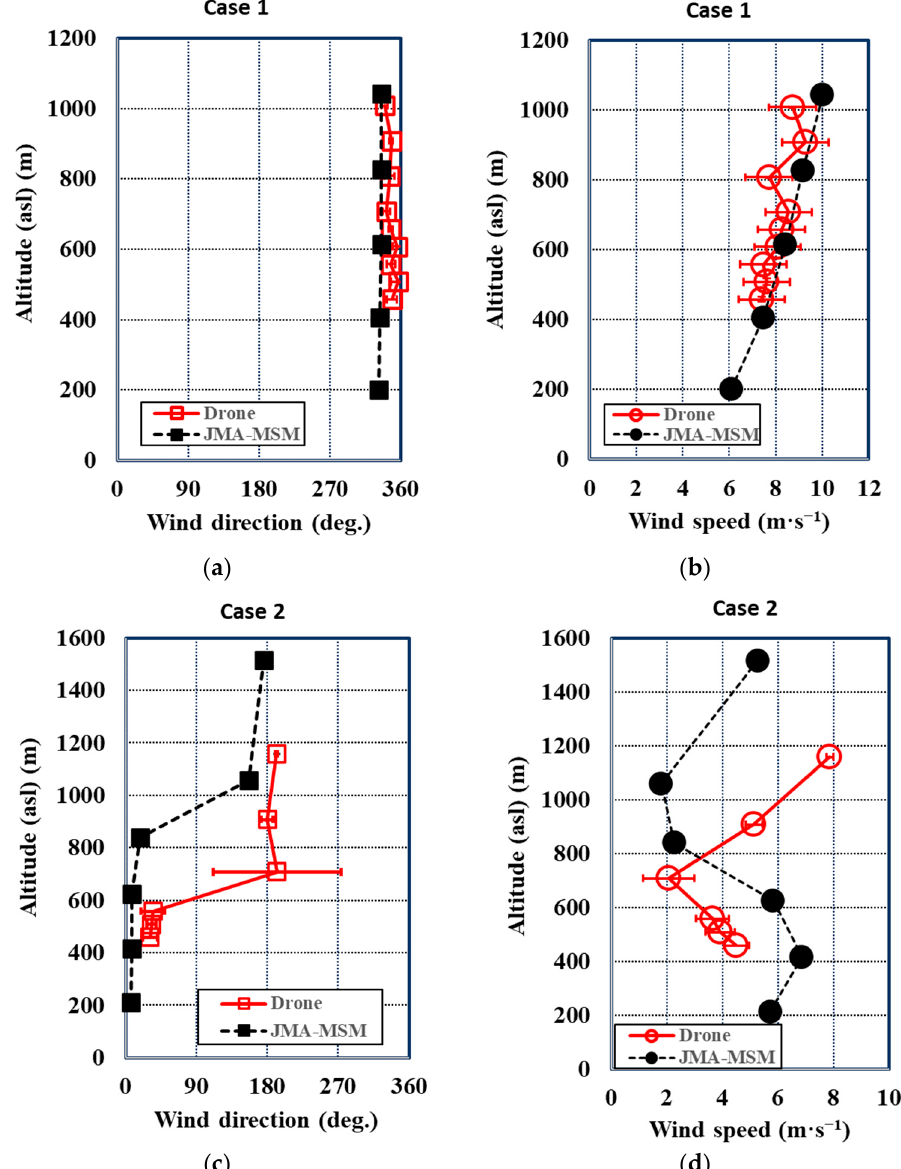
Figure 8. Comparison between vertically moving drone (Protocol B) and objective analysis values derived from JMA-MSM: ( a , c ) wind direction profile and ( b , d ) wind speed profile. Drone profiles were obtained from the averages of Runs C-1 to C-4 in Case 1, and Runs C-5 to C-7 in Case 2. The error bars represent the standard deviation of drone measurements.